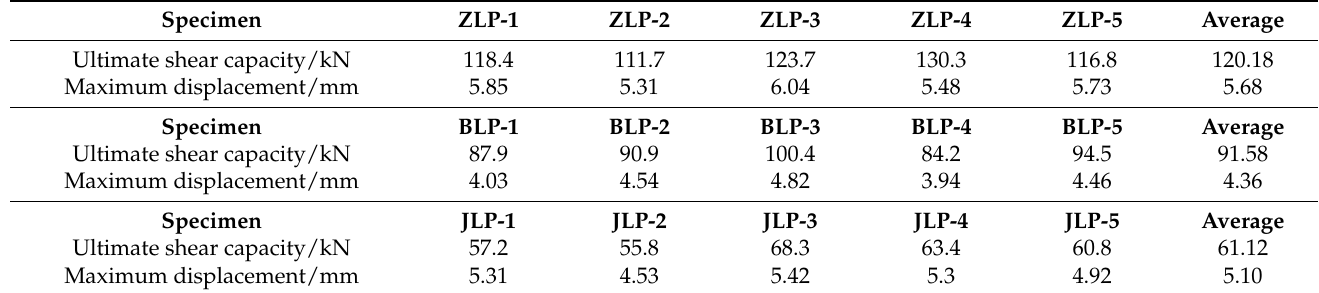
Table 3. Ultimate shear capacity under three conditions.